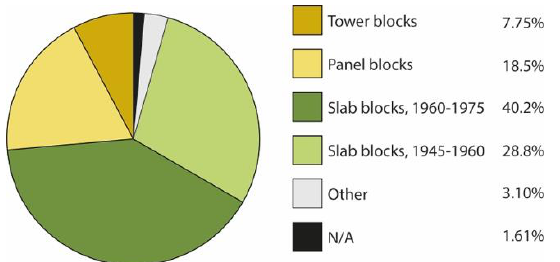
Figure 6. The predicted distribution of building types in the multifamily building stock from 1945–1975. N/A values were generated if one or more of the features in the prediction model were missing.